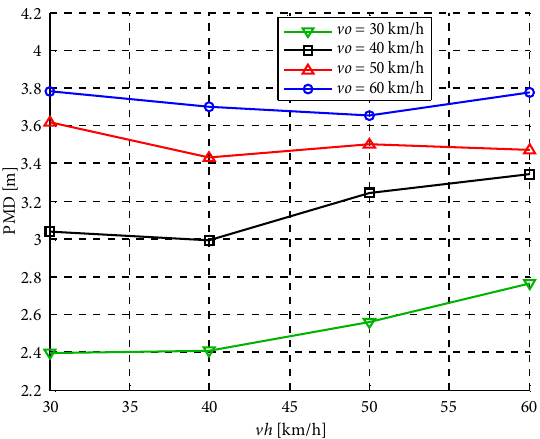
Fig. 5. Change in PMD with speed ( vo represents the speed of the oncoming vehicle; vh represents the speed of the host